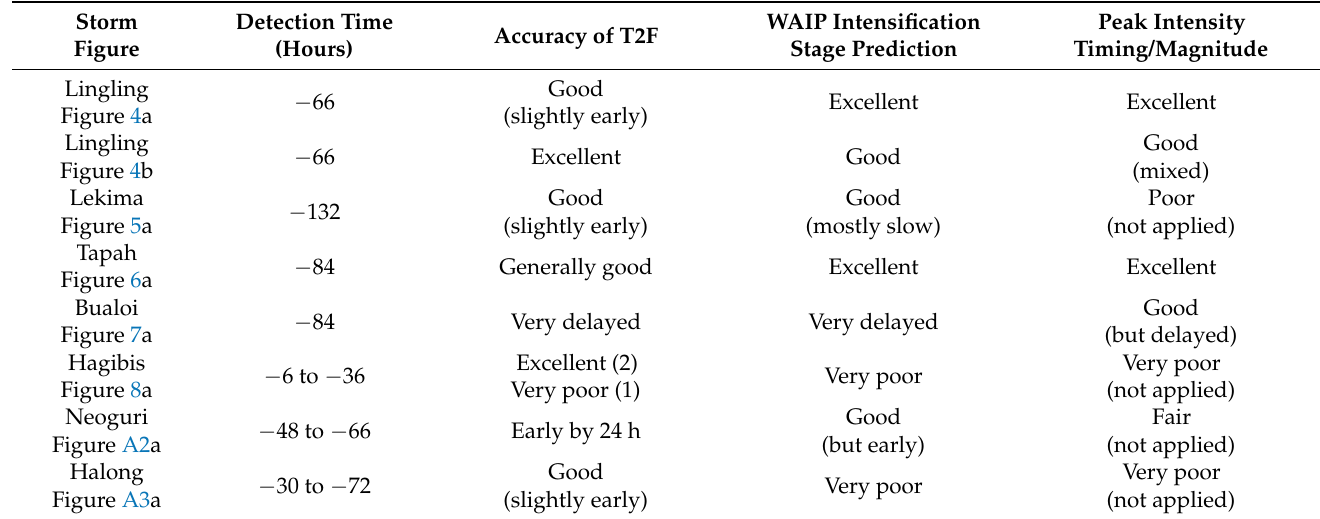
Table 1. Summary of the performance for four objectives of the modified WAIP for the tropical cyclones in this study. Storm Detection Time